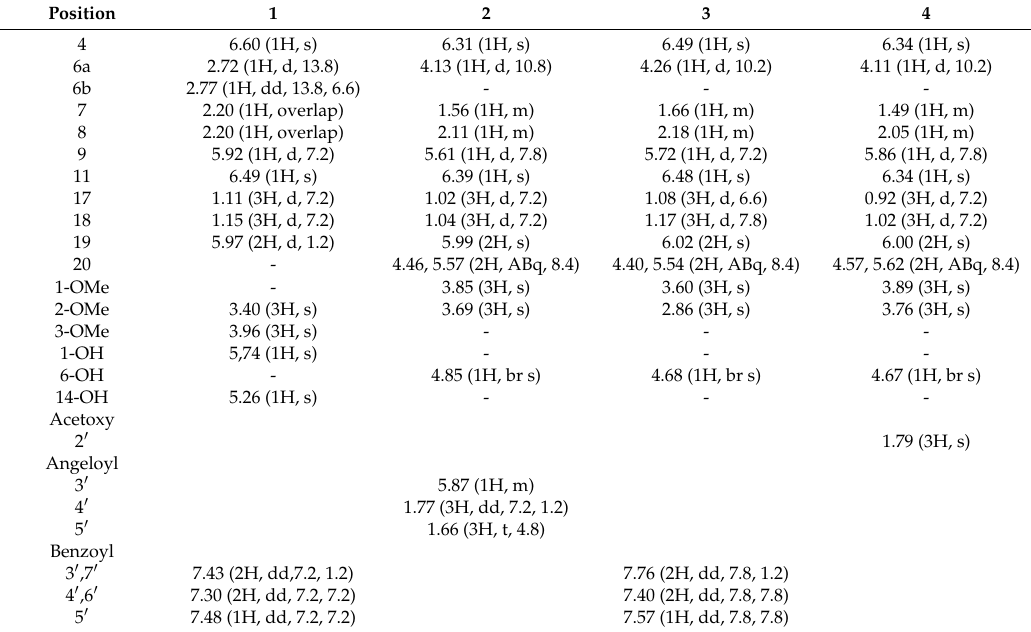
Table 1. 1 H-NMR data of compounds 1 – 4 (CD 3 OD, δ in ppm, J /Hz, 600